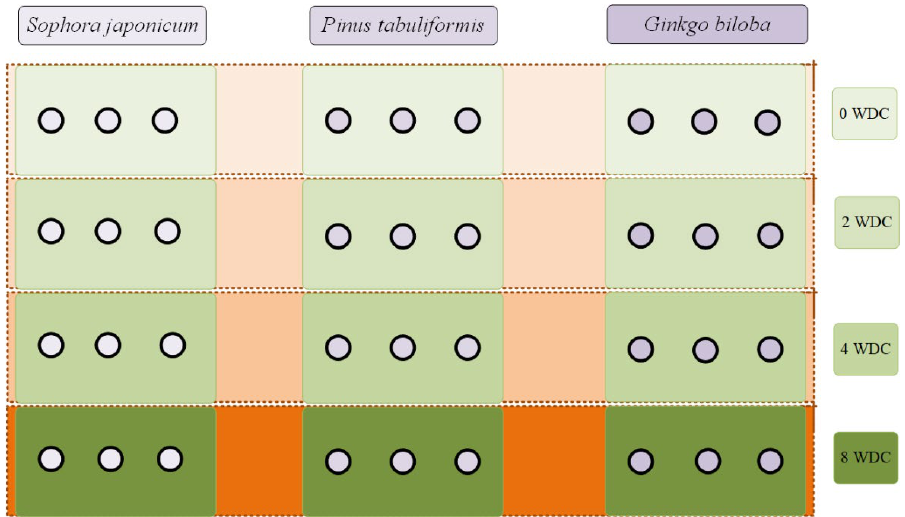
Figure 1. A schematic diagram of the experimental setup, illustrating the frequencies of DWC for three woodland soils.